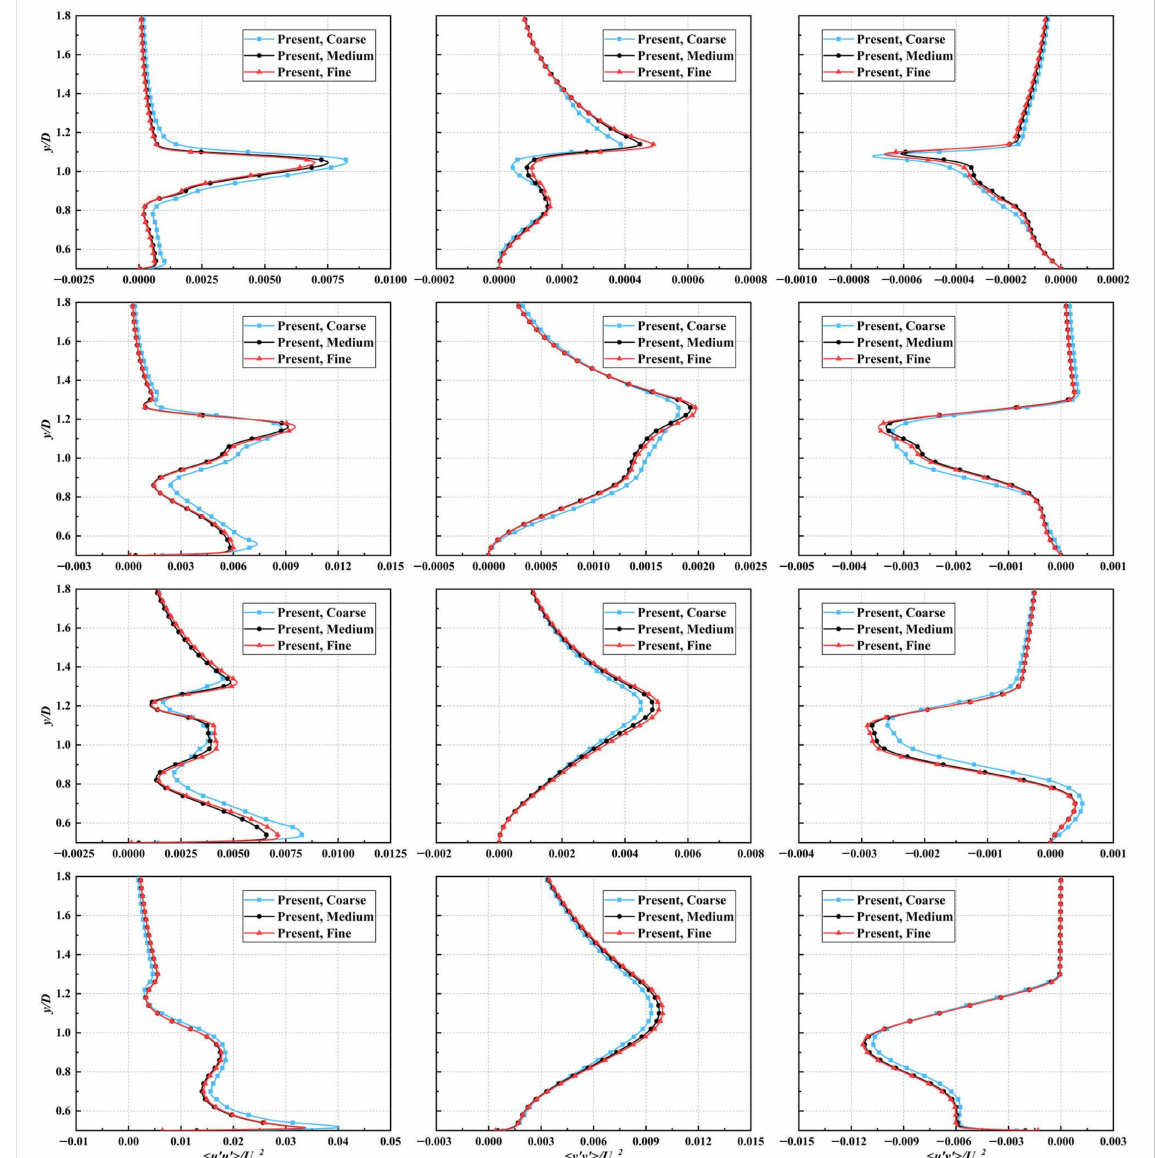
Figure 6. Profiles of time-averaged Reynolds normal stress < u (cid:48) u (cid:48) >/ U 2 ∞ ( left ), < v (cid:48) v (cid:48) >/ U 2 ∞ ( middle ), and Reynolds shear stress < u (cid:48) u (cid:48) >/ U 2 ∞ ( right ). The first, second, third, and fourth rows correspond to locations of x/D = − 1.25, 0, 1.25, and 2.5,